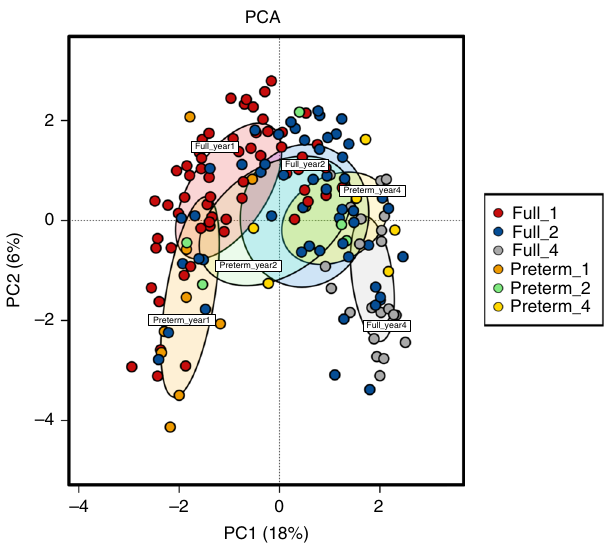
Fig. 4 Factors in fl uencing separation of samples based on beta diversity PCA + using operational taxonomic units (OTUs; top 1000 OTUs) and metadata from infants at years one, two and four. Source data are provided as a Source Data fi